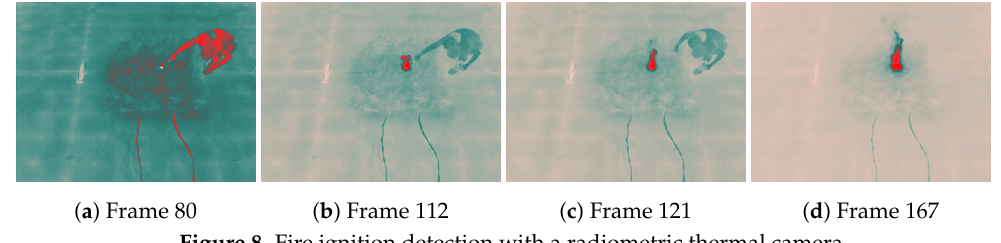
Figure 8. Fire ignition detection with a radiometric thermal